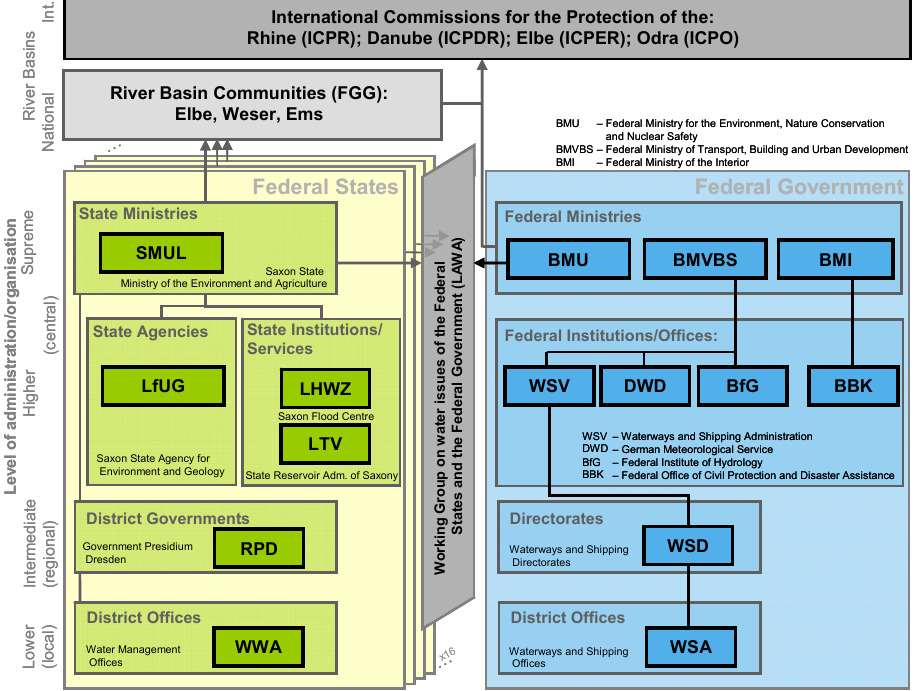
Figure 1: General organization plan of water management and related authorities in Germany in 2011, i.e. those relevant for floods. The number of levels at each federal state may vary. Also, numerous reforms have altered the organizational structure during the 20th century (ongoing process!). For the federal states the administrative bodies are given as examples for the state of Saxony (dating to 2002).